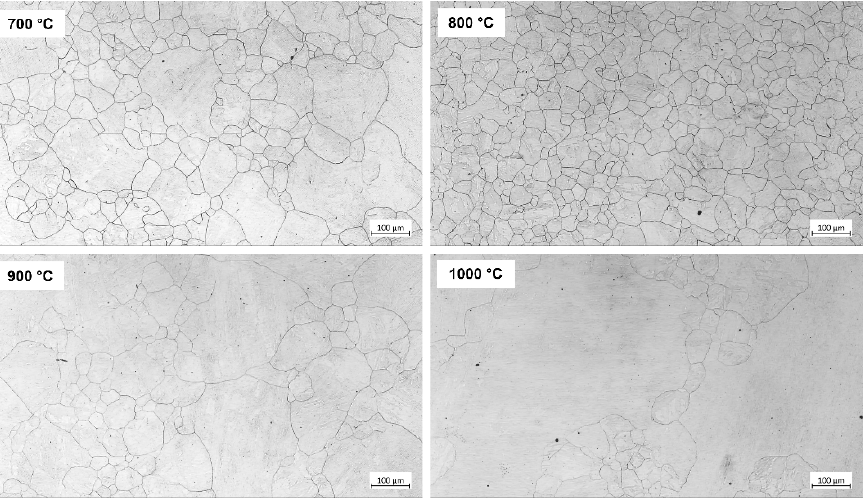
Figure 11. Prior austenite grains from steel B tested with Gleeble at different temperatures without deformation after etching. deformation after